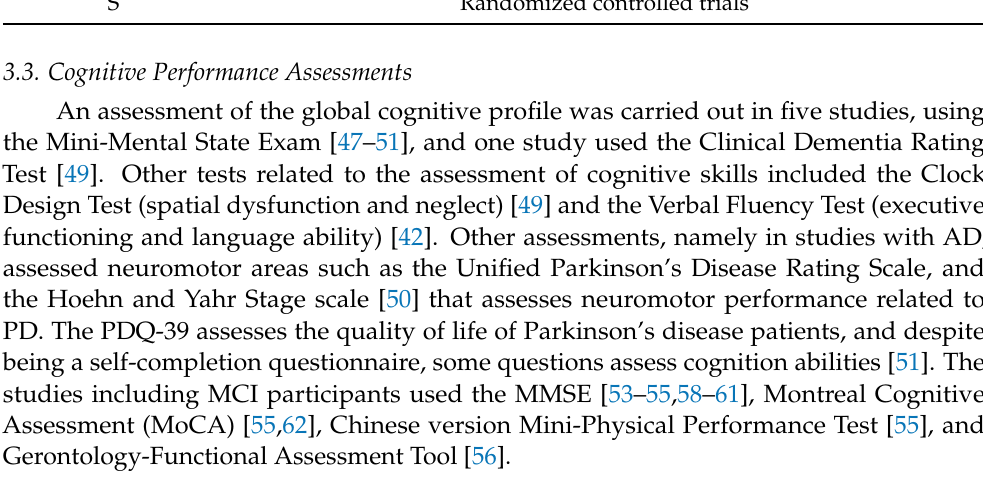
Table 2. Presentation of the study target following the acronym PICOS. P Older adults with neurodegenerative disorders I Group class, supervised, and long-term MEP. alternative active